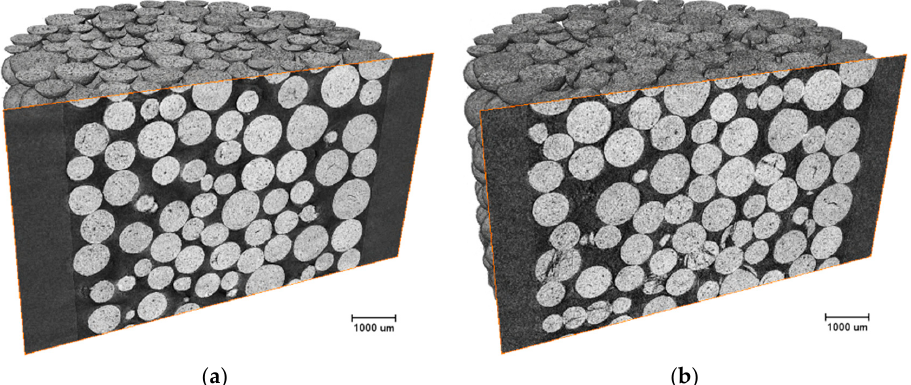
Figure 1. A ceramic proppant pack: ( a ) slightly loaded; ( b ) after axial stress impact.